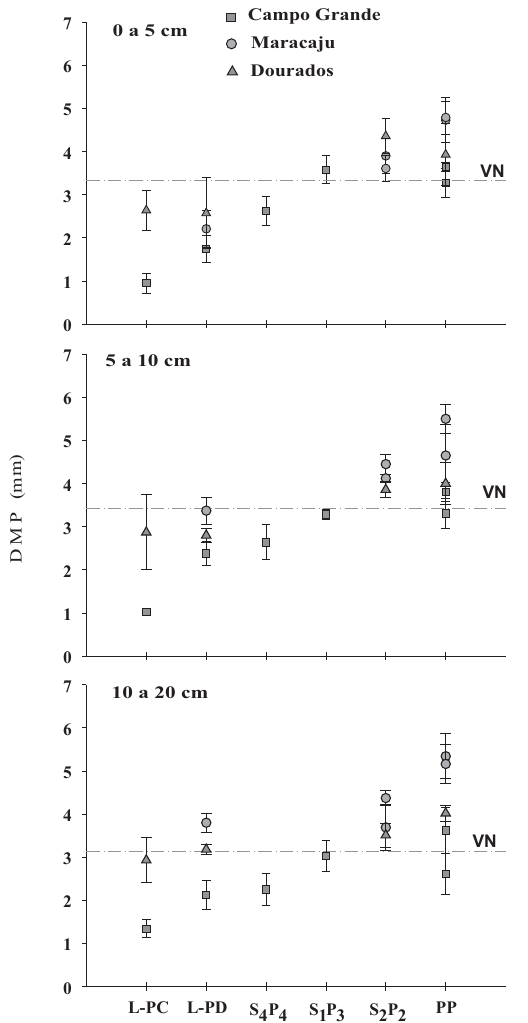
Figura 2. Relação entre carbono orgânico total (COT) Figura 1. Variações do diâmetro médio ponderado do solo e o índice de estabilidade dos agregados (DMP) dos agregados estáveis em função de (IEA), na camada de 0 a 20 cm de Latossolos sob sistemas de manejo com lavouras e da sistemas de manejo em experimentos de longa intensidade de presença de pastagens, em três duração em Mato Grosso do Sul. L-PC: lavouras camadas do solo e experimentos de longa em plantio convencional; L-PD: lavouras em duração em Mato Grosso do Sul. D: Dourados; plantio direto; S P : rotação soja por 4 anos – M: Maracaju; C: Campo Grande; L-PC: lavouras 4 4 pastagem ( P. maximum ) por 4 anos; S P : rotação em plantio convencional; L-PD: lavouras em 1 3 soja por um ano – pastagem ( B. brizantha ) por P : rotação soja por 4 anos – plantio direto; S 4 4 3 anos; S P : rotação soja por 2 anos – pastagem pastagem ( P. maximum ) por 4 anos; S P : rotação 2 2d 1 3 P : rotação soja por ( B. decumbens ) por 2 anos; S soja por um ano – pastagem ( B. brizantha ) por 2 2b 2 anos – pastagem ( B. brizantha ) por 2 anos; PP : 3 anos; S P : rotação soja por 2 anos – pastagem d 2 2 pastagem permanente ( B. decumbens ); PPb: ( B. decumbens ) por 2 anos; PP: pastagem pastagem permanente ( B. brizantha ); VN: permanente ( B. decumbens ); VN: vegetação vegetação natural (média dos três locais).